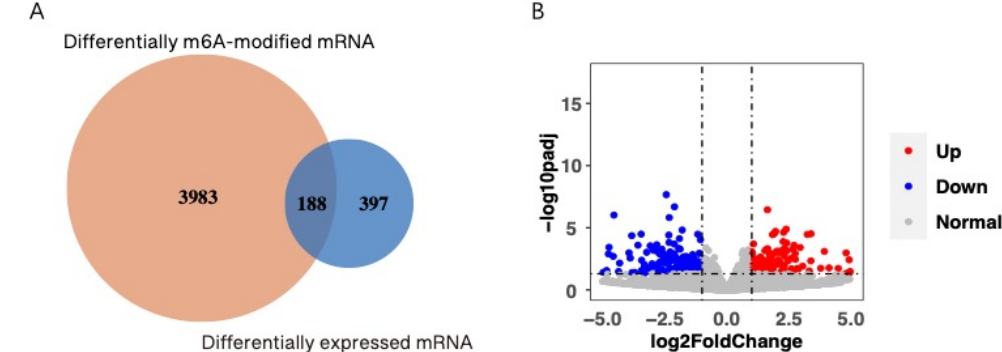
Figure 4. ( A ) Differences in m6A-modified mRNA and mRNA expression between BLS and control groups. ( B ) Volcanic map of mRNA differentially expressed between the two groups.